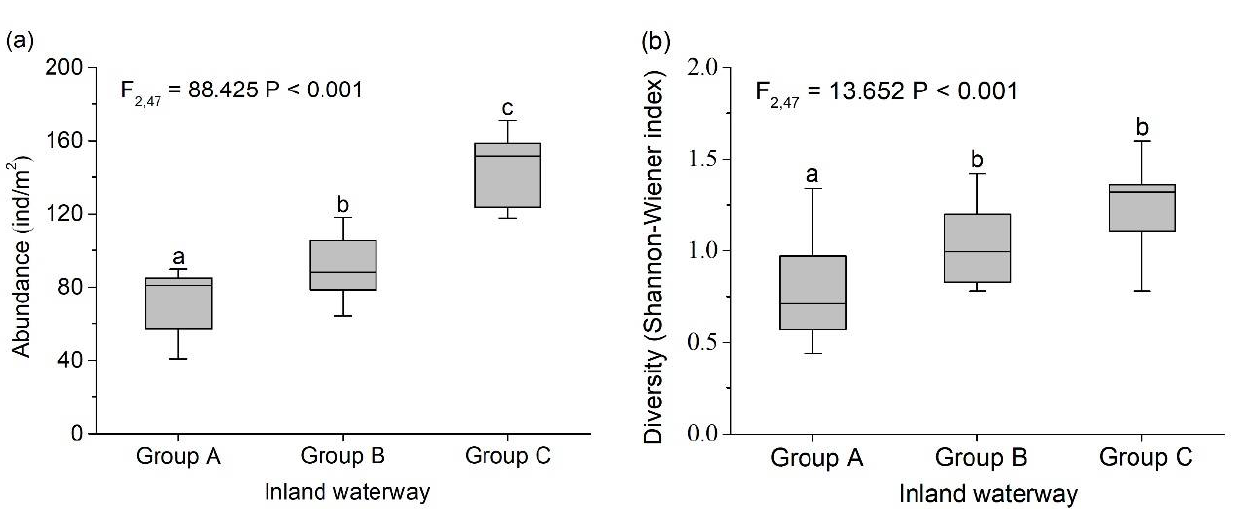
Figure 4. Box plots of ( a ) benthic macroinvertebrate abundance (no. of individuals per square meter) at sampling sites with different levels of traffic and at different stages of construction of the waterway and ( b ) benthic macroinvertebrate diversity (the Shannon–Wiener diversity index). Bars marked with the same lowercase letters were not significantly different according to Tukey’s multiple comparison test. Vertical bars show standard